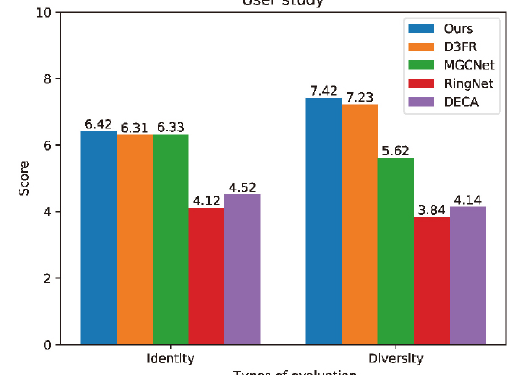
Fig. 10 Comparison with D3FR [34] and MGCNet [72] on LFW samples. The reconstruction results are the same person under different conditions. The third and sixth rows are the error between two meshes in the same column.